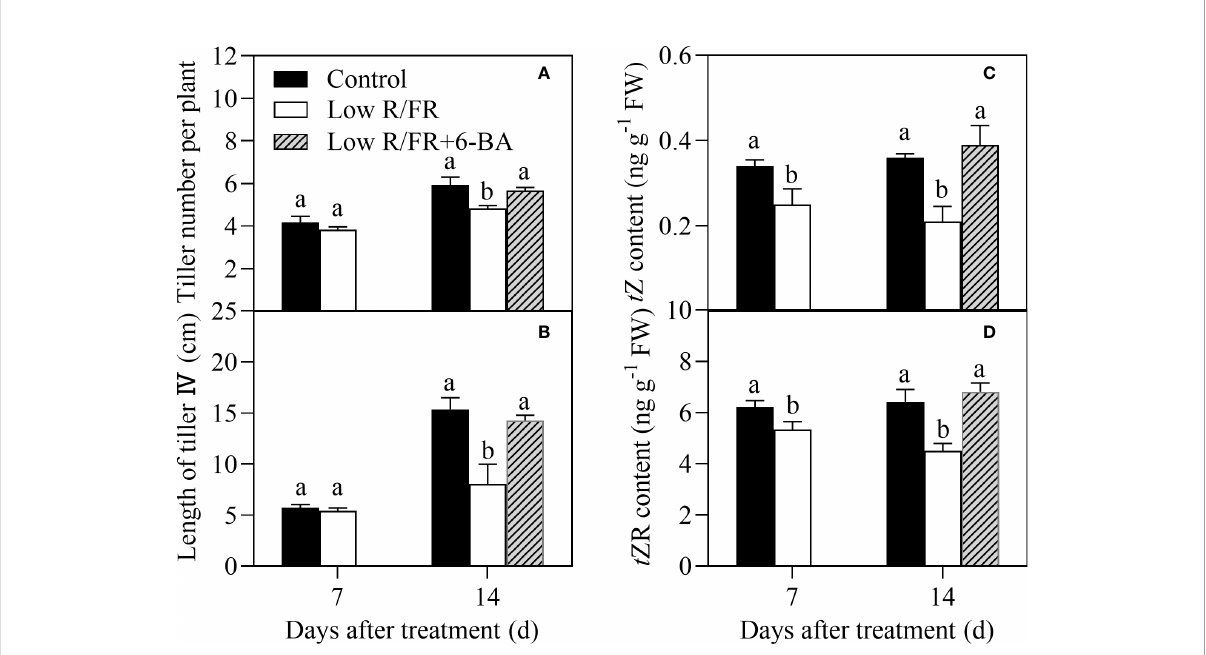
FIGURE 7 Effect of root application 6-BA on tiller number and tiller IV growth under low R/FR conditions (hydroponic experiment). Tiller numbers per plant (A) , length of tiller IV (B) and levels of t Z (C) and t ZR (D) in tiller nodes were tested at 7, 14 DAT. Data are the means of three biological replicates ± SE, and the lowercase letters denotes a statistically remarkable difference ( P < 0.05) between treated and control